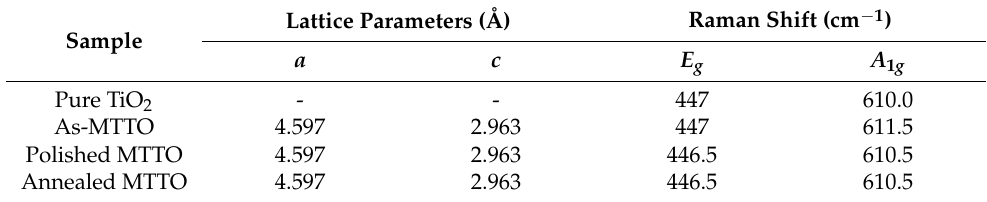
Table 1. Lattice parameters and Raman shift of pure TiO 2 and as-, polished and annealed MTTO